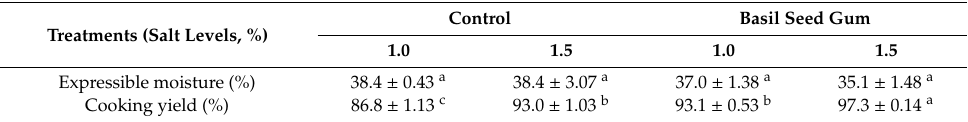
Table 6. Expressible moisture and cooking yield of low-fat sausages with basil seed gum at di ff erent salt levels.